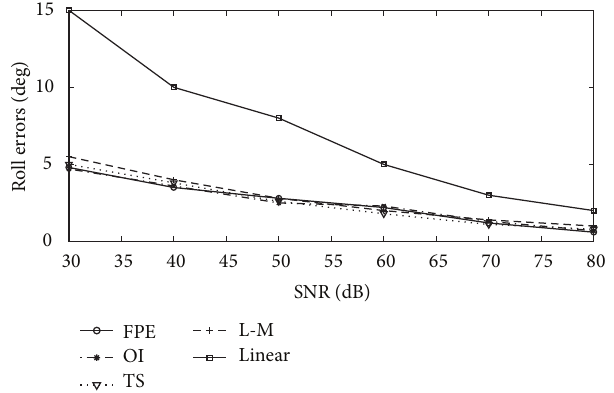
F 5: Rotation errors versus SNR.